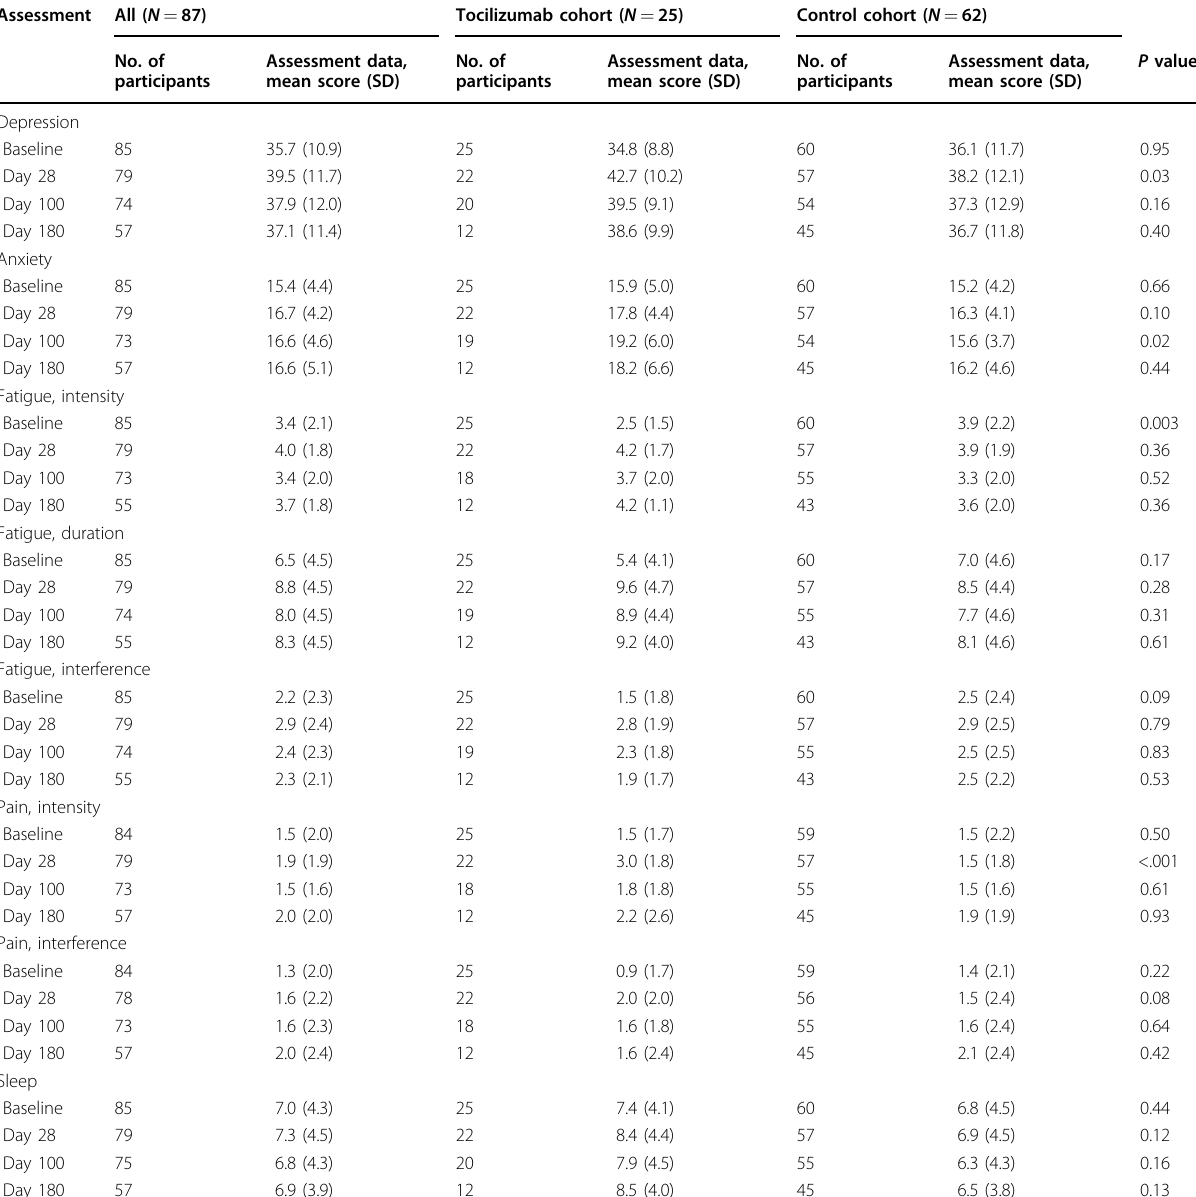
Table 2 Quality of life patient-reported outcomes at baseline, day 28, day 100, and day 180 post transplant. Assessment All ( N =